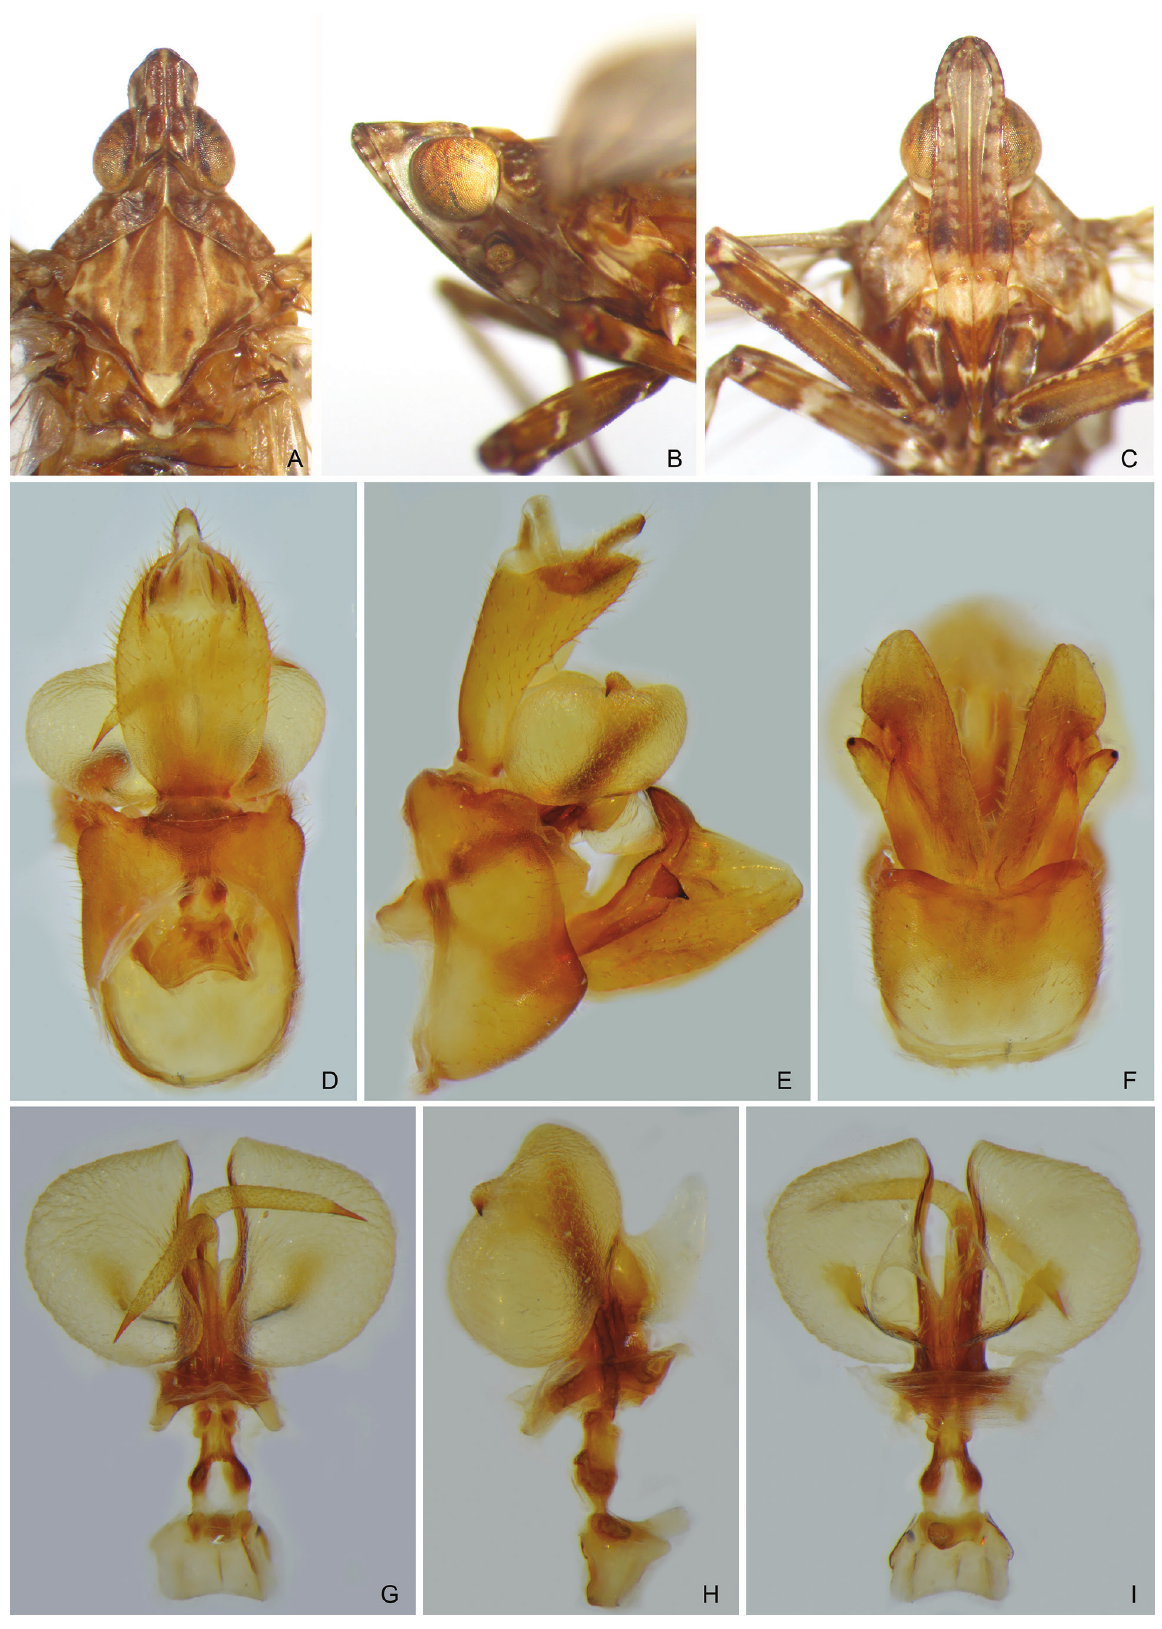
Figure 8. Orthopagus lunulifer Uhler. ( A ) Head, pronotum and mesonotum, dorsal view. ( B ) Head and pronotum, lateral view. ( C ) Head and pronotum, ventral view. ( D ) Male segment X and pygofer, dorsal view. ( E ) Male pygofer, gonostyles, and segment X, lateral view. ( F ) Male pygofer and gonostyles, ventral view. ( G ) Aedeagus, dorsal view. ( H ) Aedeagus, lateral view. ( I ) Aedeagus, ventral